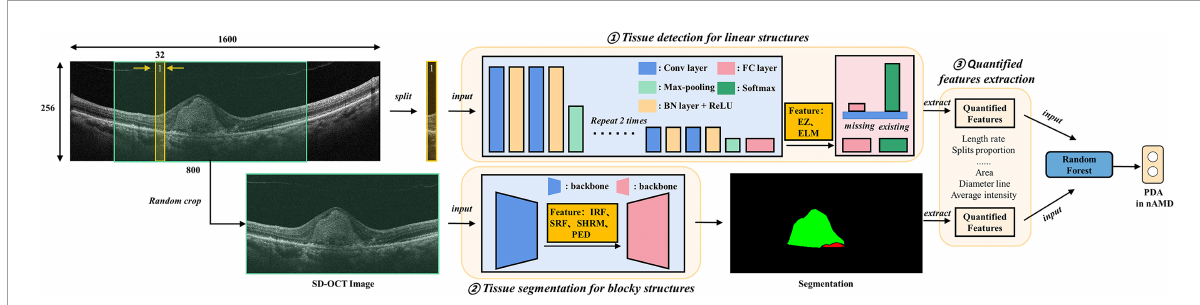
FIGURE1 Algorithm architectures and training protocol. Deep learning (DL)-based methods were introduced to extract quantified features from original spectral domain optical coherence tomography (SD-OCT) as biomarkers. The algorithm includes three parts, namely, tissue detection for linear structures, including ellipsoid zone (EZ) and external limiting membranes (ELM); tissue segmentation for blocky structures including intraretinal fluid (IRF), subretinal fluid (SRF), subretinal hyperreflective material (SHRM), and pigment epithelium detachment (PED); final quantified features (e.g., the areas and diameter lines of IRF, SRF, SHRM, and PED) extraction from the above